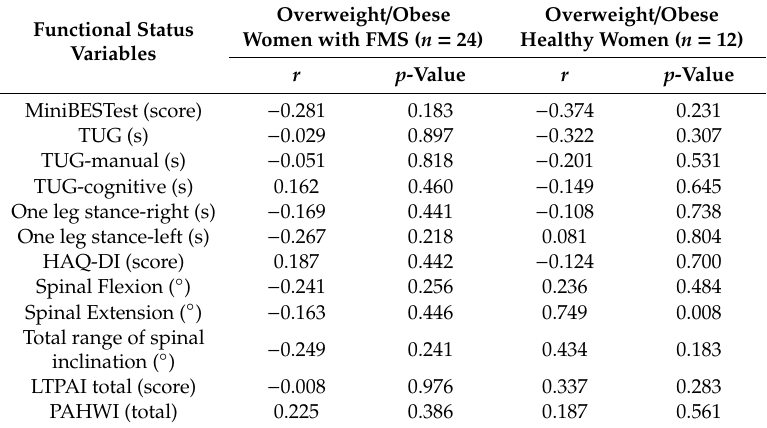
Table 3. Spearman correlation coe ffi cients (r) between functional status and BMI in overweight / obese FMS patients and healthy